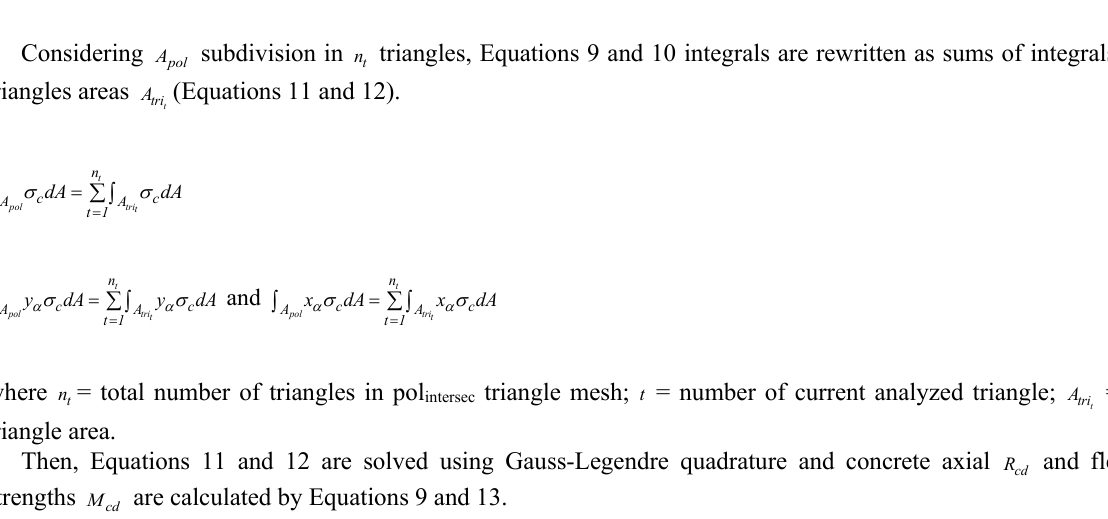
Considering subdivision in triangles, Equations 9 and 10 integrals are rewritten as sums of integrals over pol A t n triangles